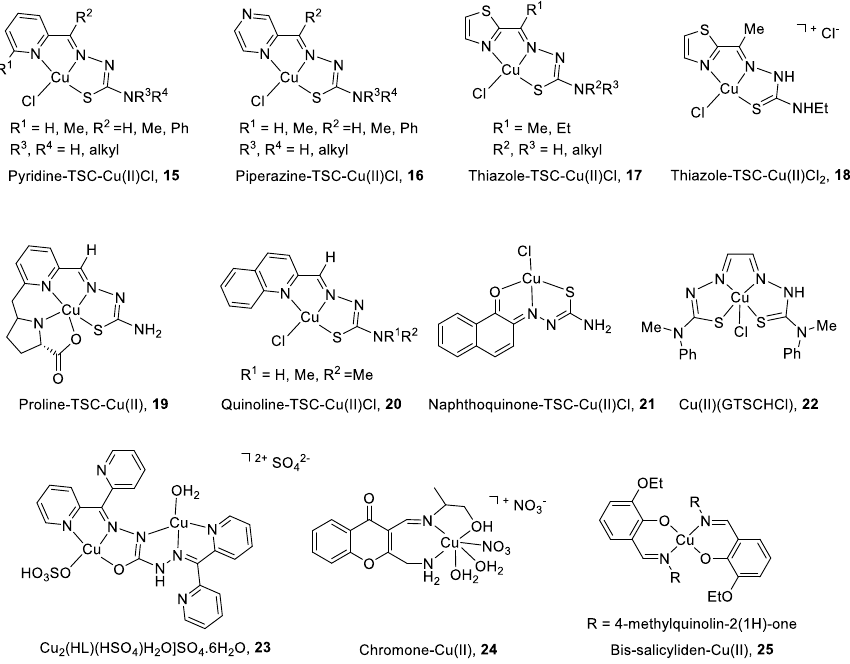
Figure 3. Structure of Cu(II) complexes as Top2 inhibitors.